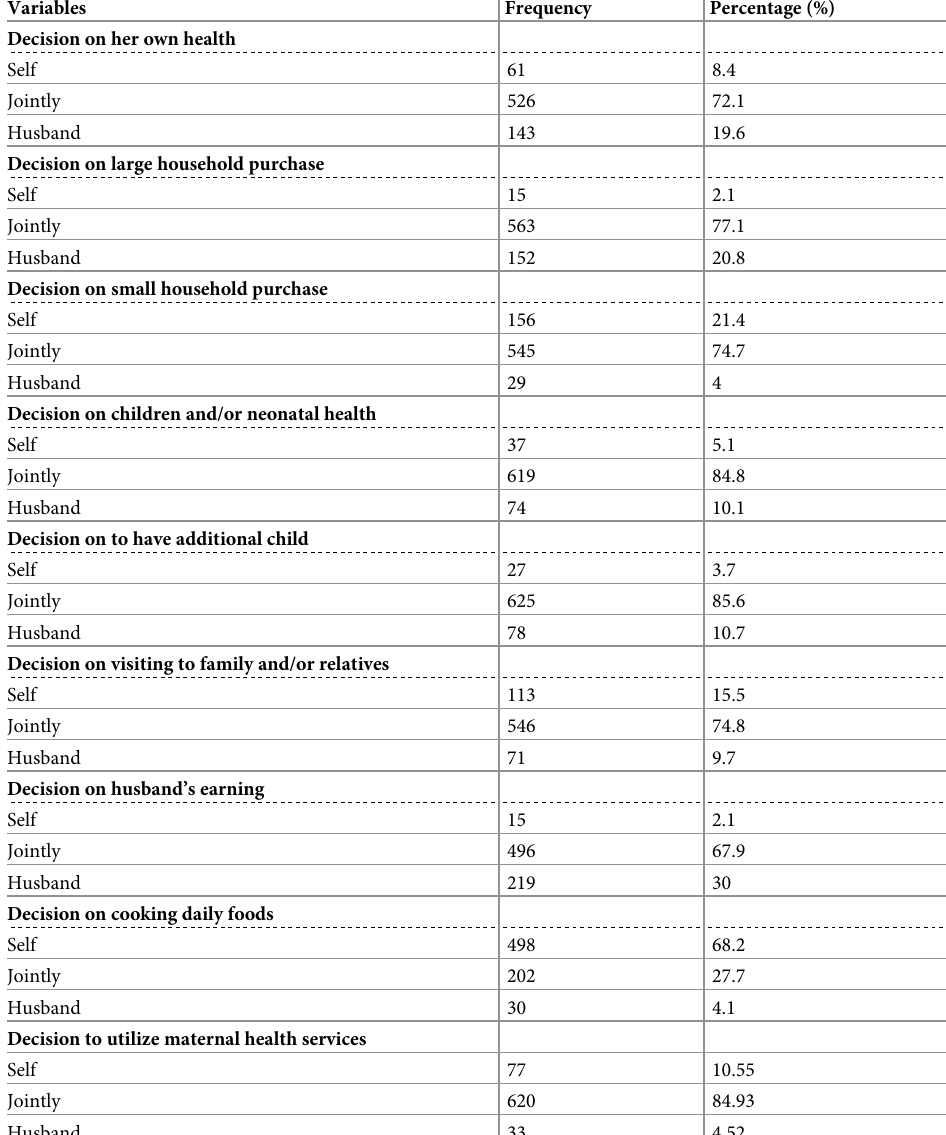
Table 3. Women’s household decision-making autonomy characteristics in Debretabor, northwest Ethiopia,